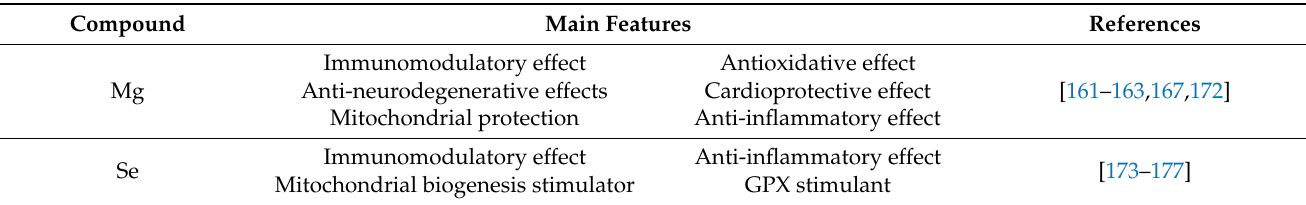
Table 2. Main effects of mineral products against aging and metabolic diseases.